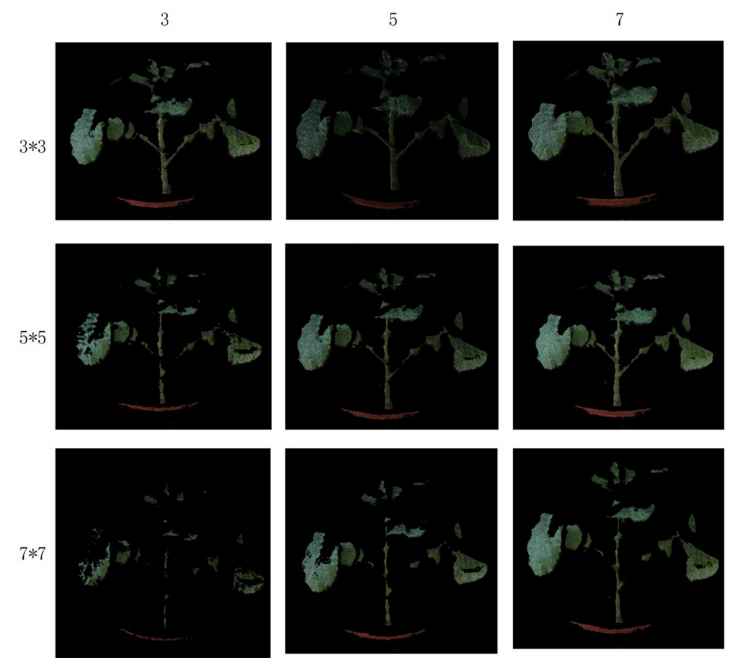
Figure 10. Comparison of the effect of different thresholds of the maximum